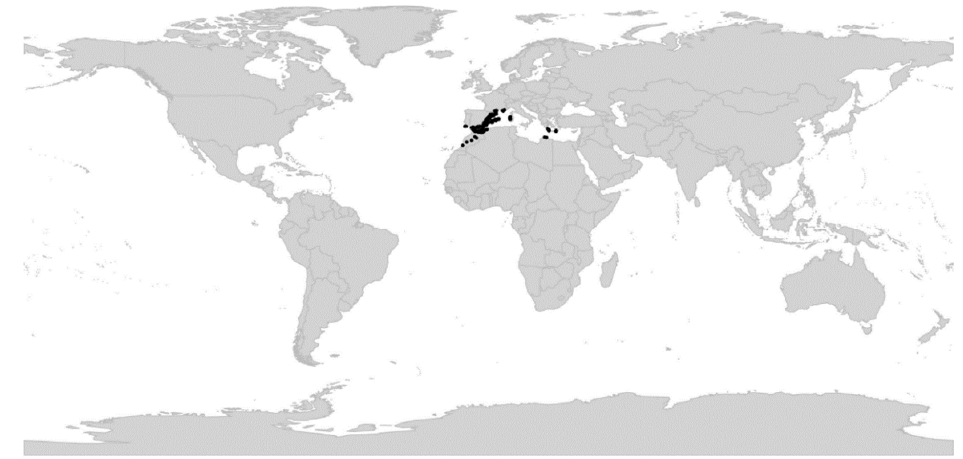
Figure 35. Global distribution of Viola sect. Xylinosium .